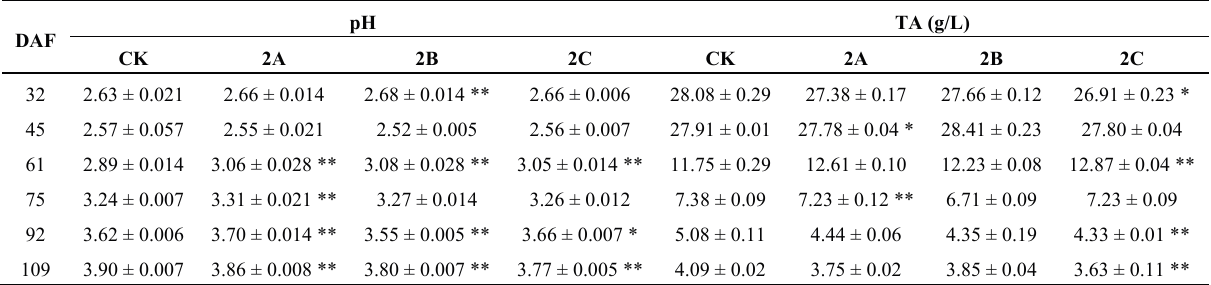
Table 3. The pH and titratable acidity of berries at the development stages in 2014.